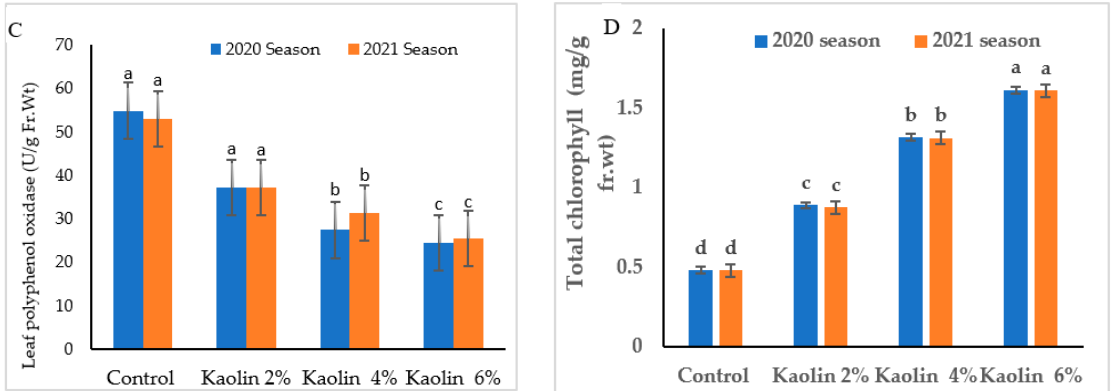
Figure 4. Effect of kaolin spray on: ( A ) leaf catalase activity (U/g Fr.Wt), ( B ) leaf peroxidase activity (U/g Fr.Wt), ( C ), leaf polyphenol oxidase (U/g Fr.Wt) and ( D ) total chlorophyll (mg/g Fr.Wt.) of Keitt mango cultivar during the seasons 2020 and 2021. Bars indicate mean values ± SE (n =9). Different letters above columns indicate significant differences among pruning treatments at p = 0.05 according to Bartlett’s test.